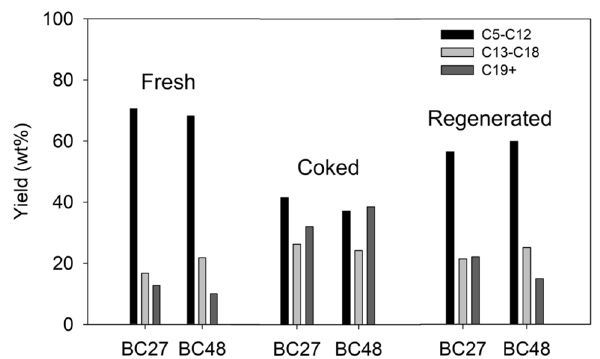
Fig. 14 Results of GC analysis of the n -heptane soluble liquids obtained during the stability test of BC27 and BC48 catalysts for the catalytic hydroconversion reaction of model plastic mixture. 500 ml autoclave reactor, 20 bar initial cold hydrogen pressure, 60 min resi- dence time, and 20:1 feed-to-catalyst ratio (by